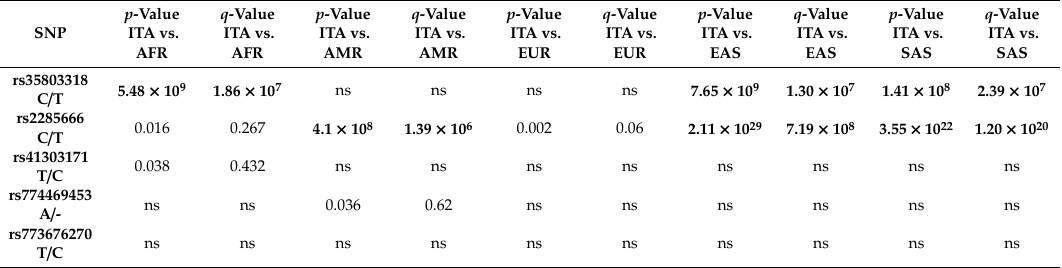
Table 2. Statistical results of the five SNVs in the Italian population versus (vs.) worldwide populations. Two-sided Fisher exact test’s p -value ( p ) showing the statistically significant di ff erences of the frequency distributions of the five ACE2 variants detected in the Italian cohort, with respect to the frequencies observed in the other populations. The q -value ( q ) show the adjusted p after multiple testing correction. The significant data are highlighted in bold. ITA: Italians; AFR: Africans; AMR: Americans; EUR: Europeans; EAS: East Asians; SAS: South Asians; ns: not significant.